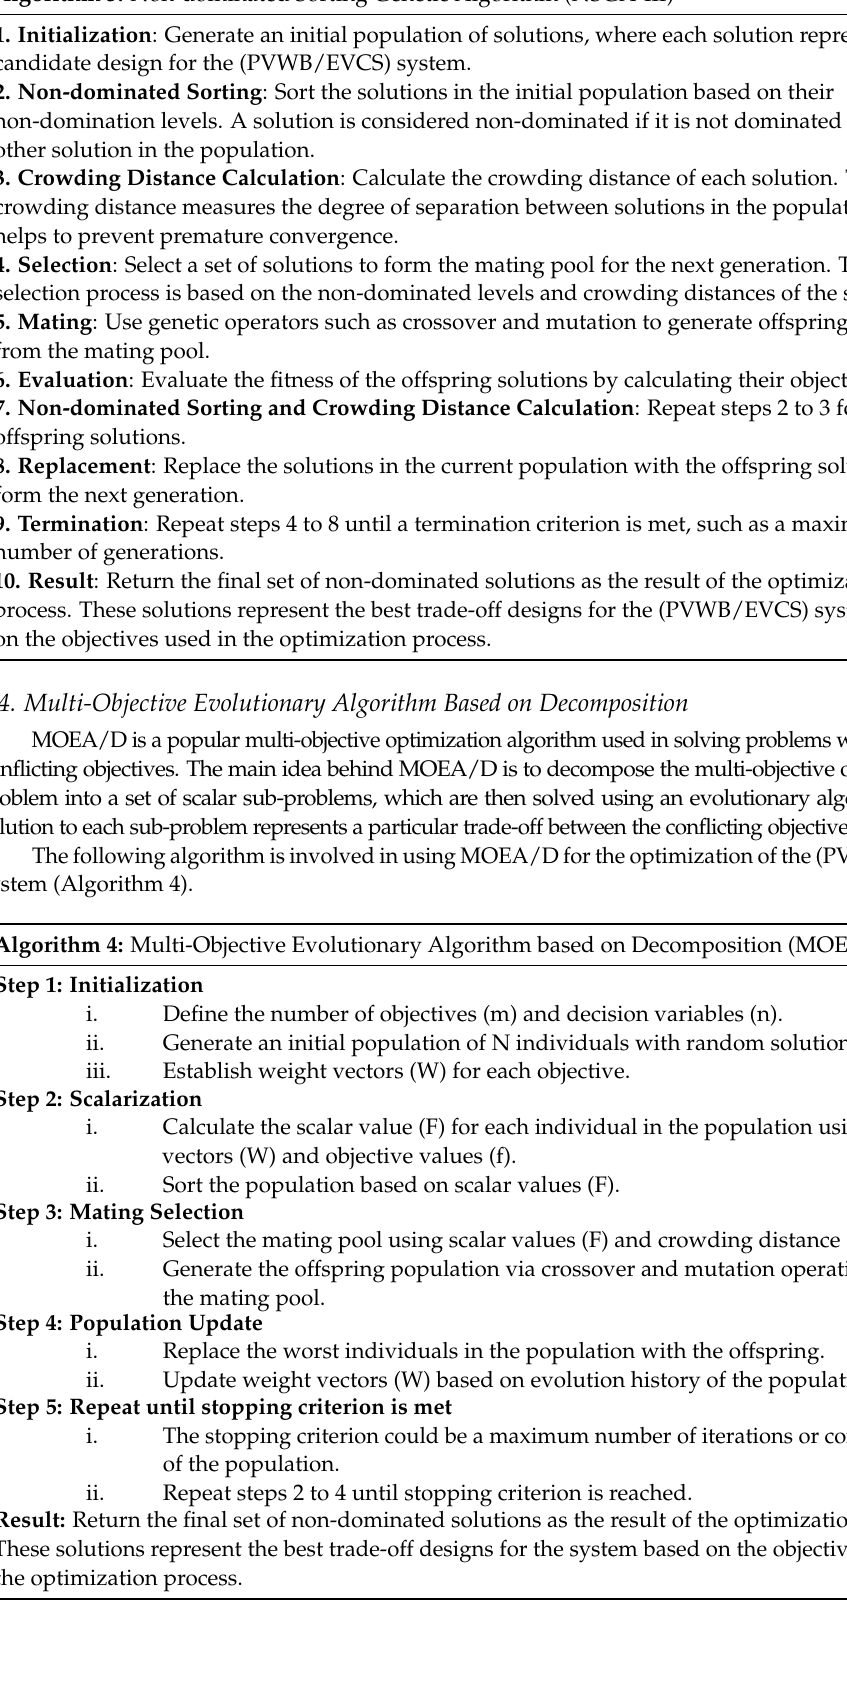
Algorithm 3: Non-dominated Sorting Genetic Algorithm (NSGA-III)